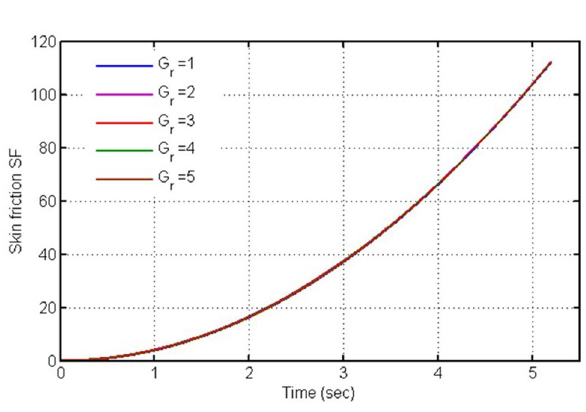
Figure 10. Plot for skin-friction versus time against Gr